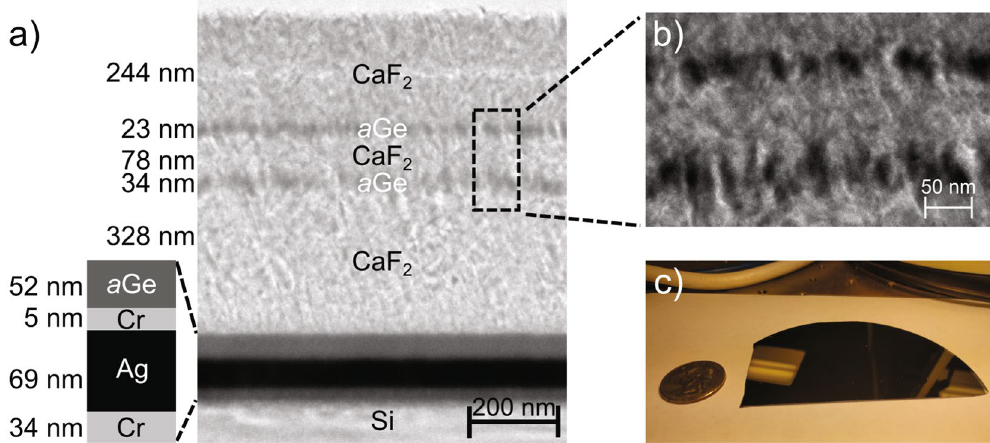
Figure 2. ( a ) Cross section transmission electron micrograph of sample. ( b ) Zoomed in region of CaF 2 and Ge layers. The gray CaF 2 layers appear columnar and mix with the black Ge layers. ( c ) Image of sample fragment from 4 inch wafer with U.S. quarter for scale. Sample fabrication is achievable at the wafer